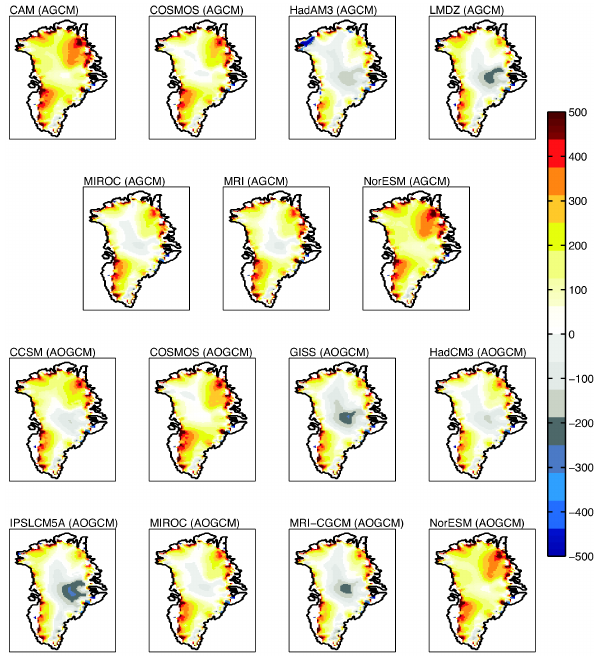
Figure 6. Ice sheet surface elevation (m) anomalies (model minus data) for the pre-industrial control relative to the observed present- day GrIS (Bamber et al., 2001) for individual AGCM and AOGCM forcings. The BASISM simulations shown here were run using BA- SISM’s standard glaciological parameters ( ∝ s = 3mmday − 1 ◦ C − 1 and ∝ i = 8mmday − 1 ◦ C − 1 , lapse rate = − 6 ◦ Ckm − 1 ) .